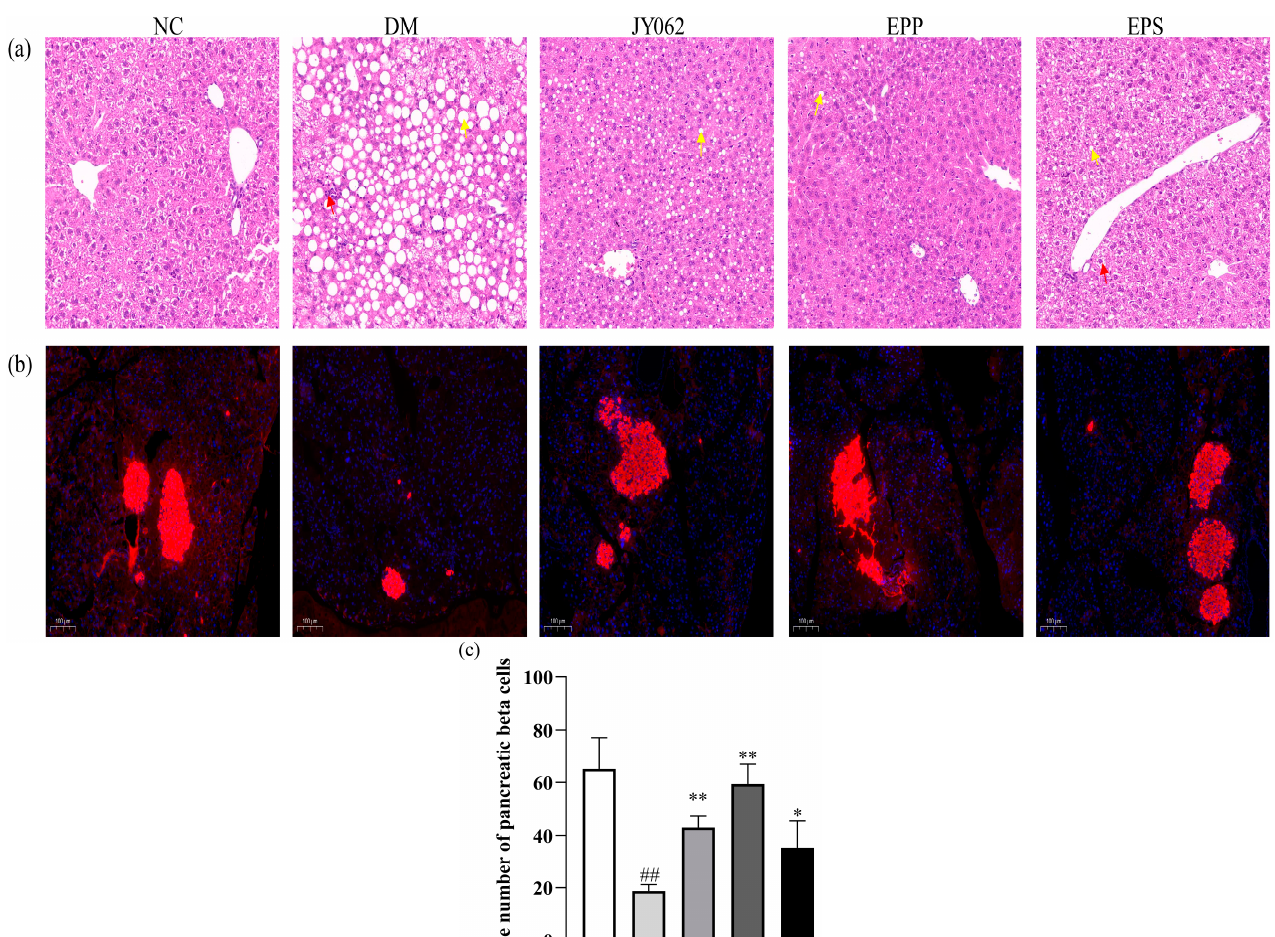
Figure 7. Effects of dietary intervention on liver and pancreas function. ( a ) The liver microsections were stained with hematoxylin-eosin (HE) (100× magnification); ( b ) immunofluorescence of insulin in pancreatic tissue; ( c ) the number of pancreatic beta cells. Data are presented as mean ± SD values. ## p < 0.01 vs. NC group; * p < 0.05, ** p < 0.01 vs. DM group.